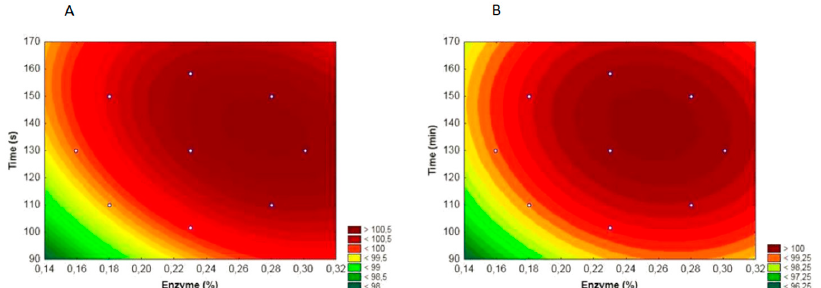
Figure 1. Effect of β -galactosidase enzymes on lactose hydrolysis of whey protein concentrate as a function of enzyme concentration (%) and time (min). A) Lactozym Pure 6500 L; B) Maxilact LGX 5000.